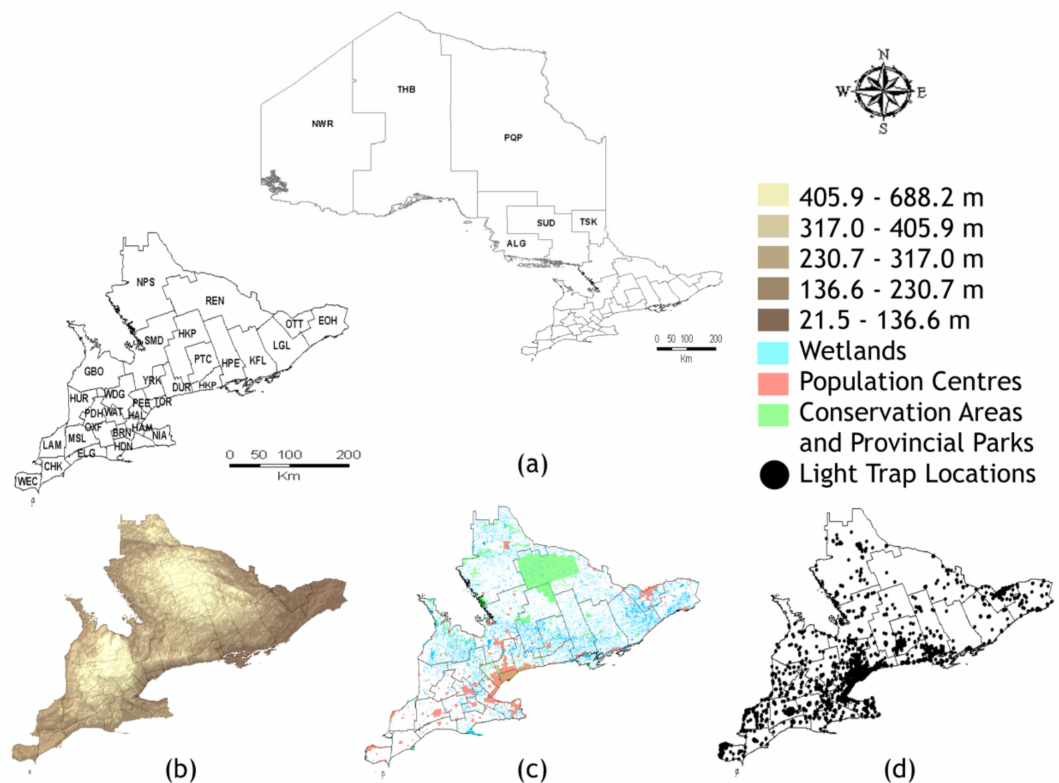
Figure 1. ( a ) Northern and southern Ontario, Canada with HU boundaries (solid black lines); ( b ) digital elevation model of southern Ontario; ( c ) map of conservation areas and provincial parks, wetlands, and population centres; ( d ) light trap locations in southern Ontario. Maps prepared in ArcGIS 10.4. Abbreviations: ALG, Algoma District; BRN, Brant County; CHK, Chatham-Kent; DUR, Durham Region; ELG, Elgin-St. Thomas; EOH, Eastern Ontario; GBO, Grey Bruce; HAL, Halton Region; HAM, City of Hamilton; HDN, Haldimand-Norfolk; HKP, Haliburton-Kawartha-Pine Ridge District; HPE,